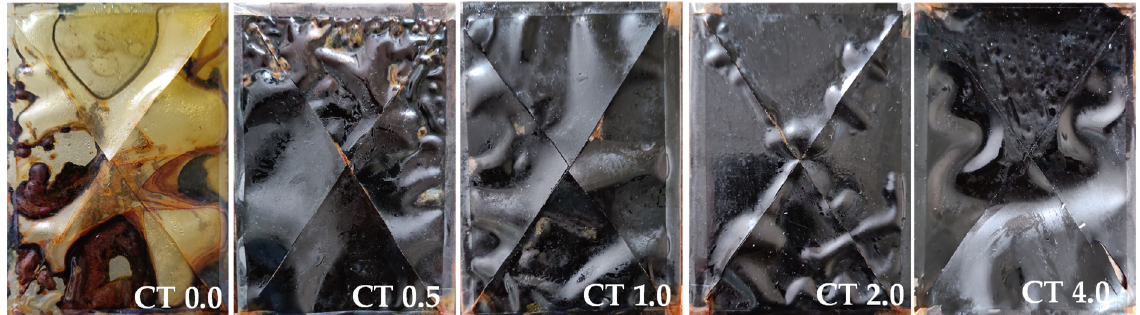
Figure 13. Salt Spray Fog Test Panels (144 h) of NIPU Composite